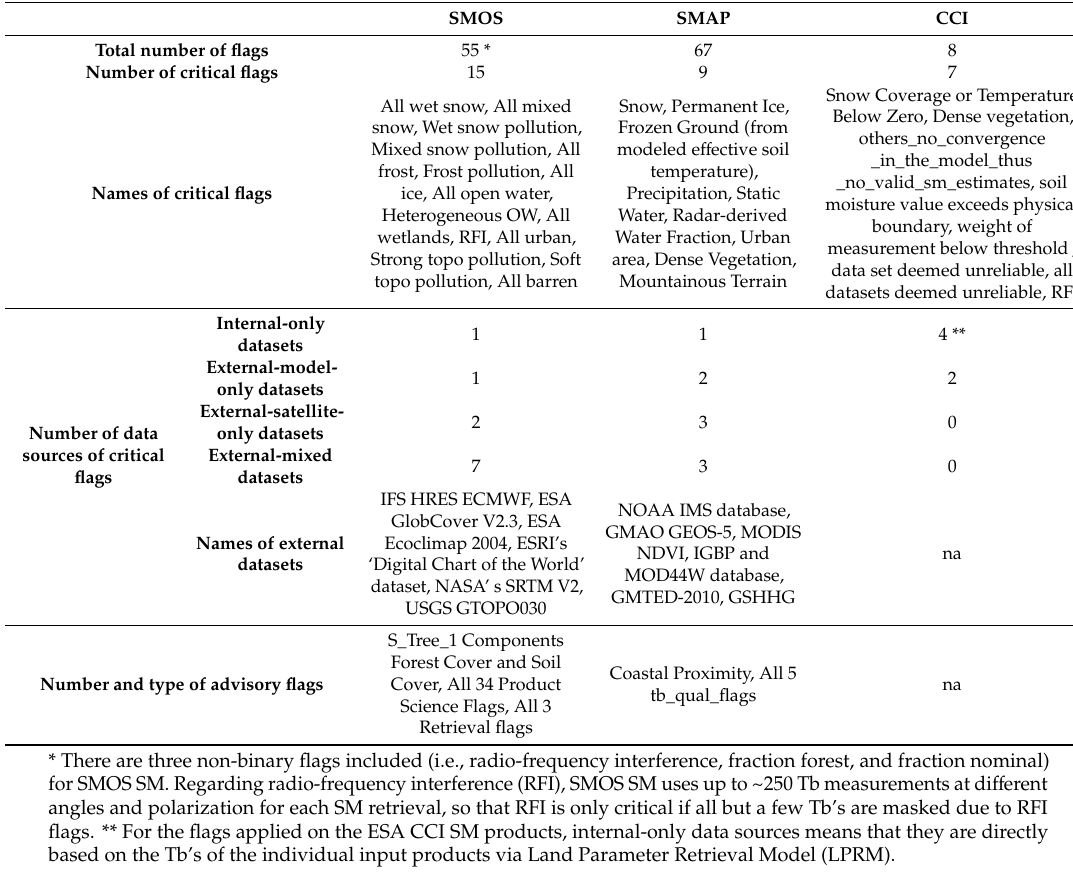
Table 2. Summarized overview of the flagging systems of the sensor datasets Soil Moisture and Ocean Salinity (SMOS) and SMAP and the multi-sensor ESA CCI SM datasets.